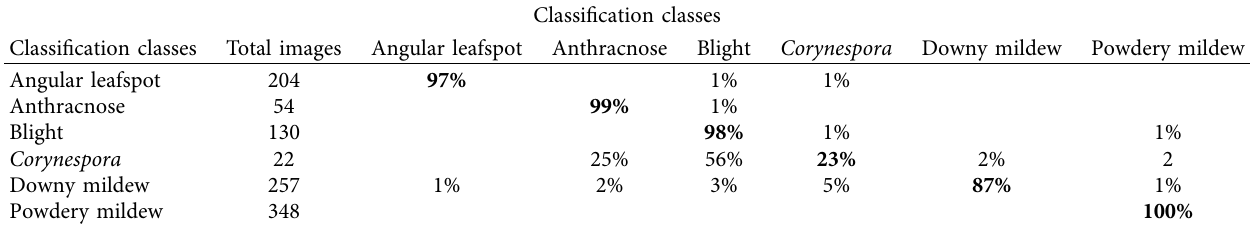
Table 4: Confusion matrix of cucumber leaf dataset of test 2 on ensemble fine KNN.